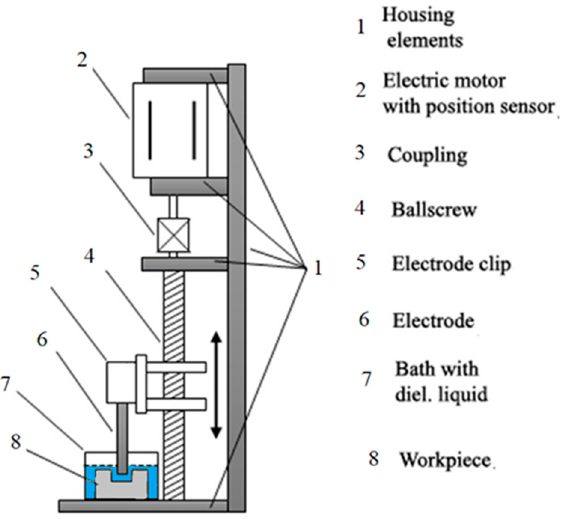
Figure 2. The mechanical part of the electrical discharge machining stand.